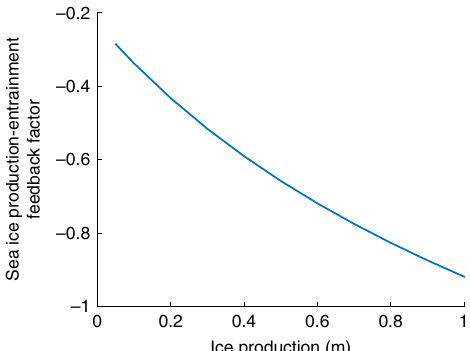
Fig. 5 Evolution of the ice production-entrainment feedback factor as a function of ice production. For each value of ice production, the entrainment is computed from the January – February 1990 – 2005 mean temperature and salinity pro fi les 115 assuming a mixed layer deepening restoring the static stability of the water column after the brine release. It is shown here for a Weddell Sea location typically covered by ice in winter (near 30°W, 65°S).